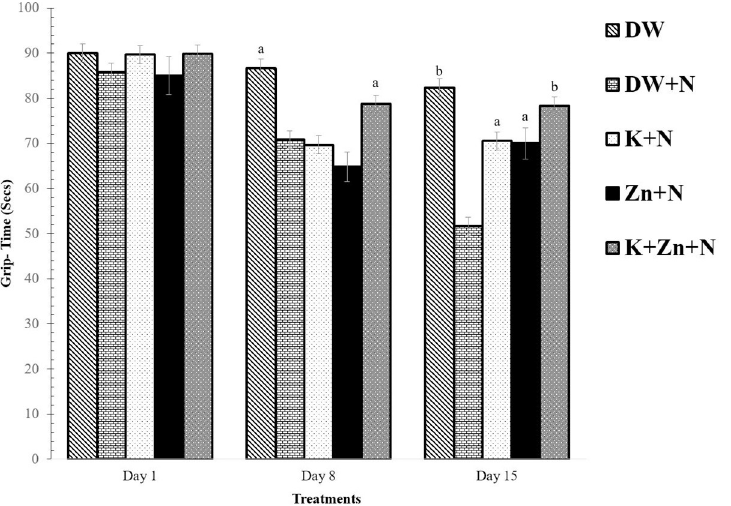
which had the least width (5.33 ± 1.45 cm, 4.33 ± 1.41cm, 3.83 ± 1.35 cm) for the respective days. Additionally, the step-down width of the group treated with zinc + noise was signifi- cantly higher (P < 0.05) compared to the kaempferol + zinc + noise treated group. Also, on day 8, the motor balance in the kaempferol + zinc + noise group was significantly lower (P < 0.05) compared to the zinc + noise and kaempferol + noise treated groups. There was no significant difference (P > 0.05) between zinc + noise and kaempferol + noise treated groups on days 8 and 15 (Fig 4).